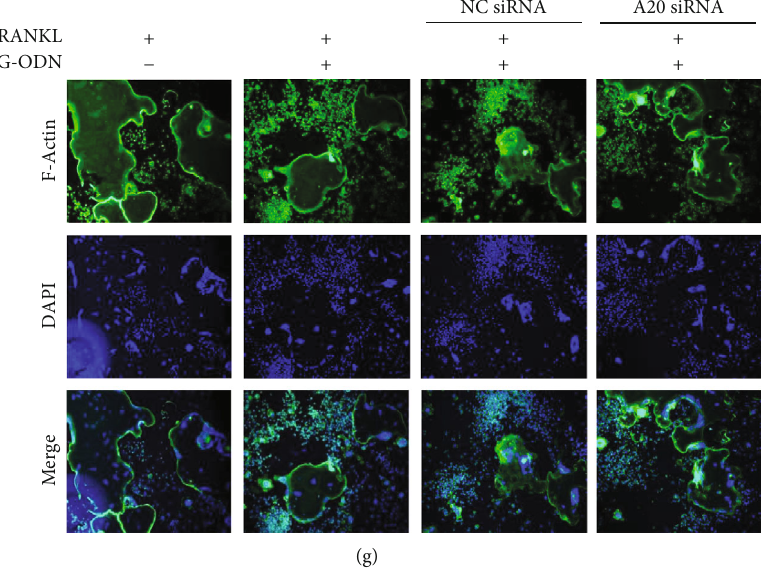
Figure 3: De fi ciency of A20 deubiquitinase restored osteoclast formation. (a) c-Fos mRNA expression in A20 knockdown cells under stimulation with both RANKL (100ng/ml) for 8 days and CpG-ODN for 6 days. (b) c-Fos, p-I κ B α , and p-NF- κ B protein expression in cells transfected with A20 siRNA under stimulation with both RANKL and CpG-ODN. (c, d) Under the same experimental conditions, osteoclast-speci fi c molecules such as NFATc1, TRAP, cathepsin K, and CA-II were measured in A20 siRNA transfected RAW 264.7 cells incubated with both RANKL and CpG-ODN. (e – g) TRAP staining, number of TRAP-positive MNCs, and F-actin ring staining in cells transfected with A20 siRNA in the presence of both RANKL and CpG-ODN were preformed, respectively. Abbreviation: NC: negative control; NFATc1: nuclear factor of activated T cells c1; TRAP: tartrate-resistant acid phosphatase; CA-II: carbonic anhydrase-II. Error bars represent standard deviation of the measurement of three separate samples ( ∗ p < 0 : 001 and ∗∗ p < 0 : 05